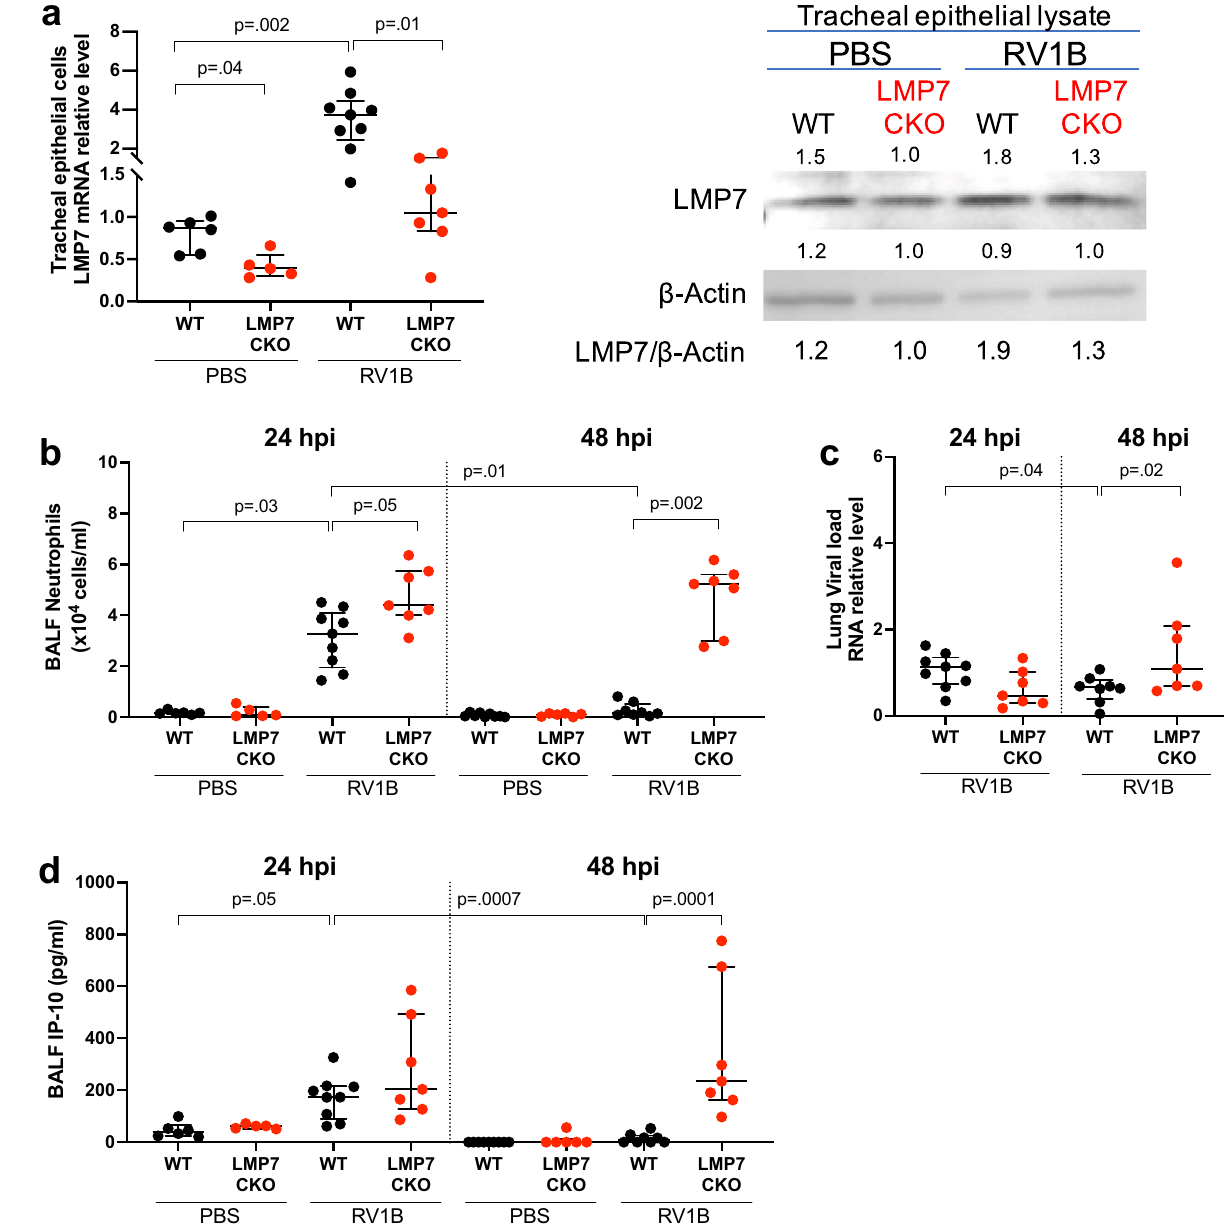
Figure 1. LMP7 in mouse airway epithelium enhances the resolution of airway inflammation and viral infection . Mice were intranasally inoculated with PBS or RV1B at 5 × 10 6 PFU/mouse and sacrificed at 24h or 48h post infection. ( A ) Relative level of LMP7 mRNA from tracheal epithelial cells isolated from individual mice, and western blot image of LMP7 protein in tracheal epithelial lysates pooled from mice in the same groups. ( B ) Total number of neutrophils in BALF. ( C ) RV load was measured in the lung by RT-qPCR and normalized to 18S rRNA gene. ( D ) IP-10 levels in BALF. Data were analyzed using Kruskal–Wallis test. n = 5–9 mice per